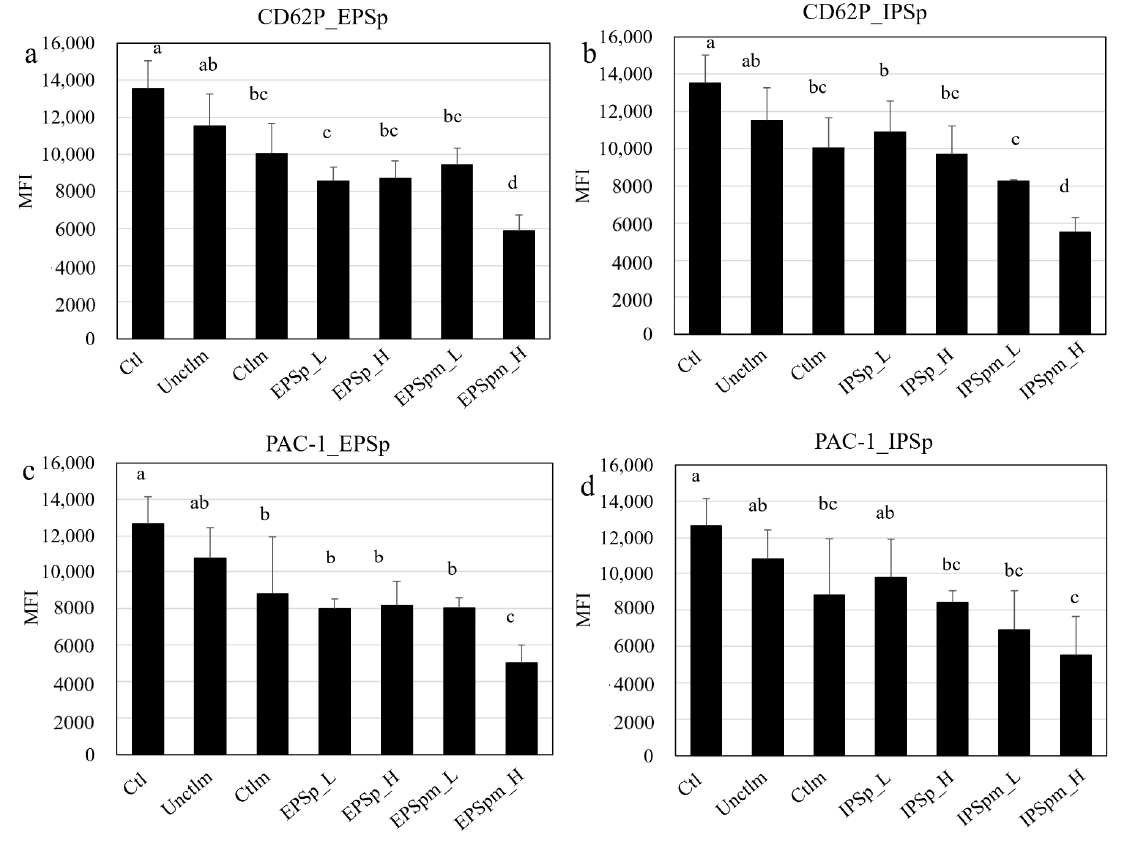
Figure 3. The effects of Cs-4 EPSp, IPSp, and their gut bacterial metabolites on human platelet acti- vation. ( a ) CD62P expression with EPSp; ( b ) CD62P expression with IPSp; ( c ) PAC-1 binding to platelets with EPSp; ( d ) PAC-1 binding to platelets with IPSp; Ctl: phosphate buffered saline; Unctlm: fecal fermentation basal medium before fecal fermentation; Ctlm: fecal fermentation basal medium after fecal fermentation; EPSp: purified Cs-4 exopolysaccharides, IPSp: purified Cs-4 intra- cellular polysaccharides. EPSpm: EPSp after fecal fermentation; IPSpm: IPSp after fecal fermenta- tion. H: 5 mg/mL for EPSp, IPSp, EPSpm and IPSpm; L: 1 mg/mL for EPSp, IPSp, EPSpm and IPSpm. Collagen: 2 μ g/mL. Data are presented as mean ± standard deviation, n = 3. Different letters indicate